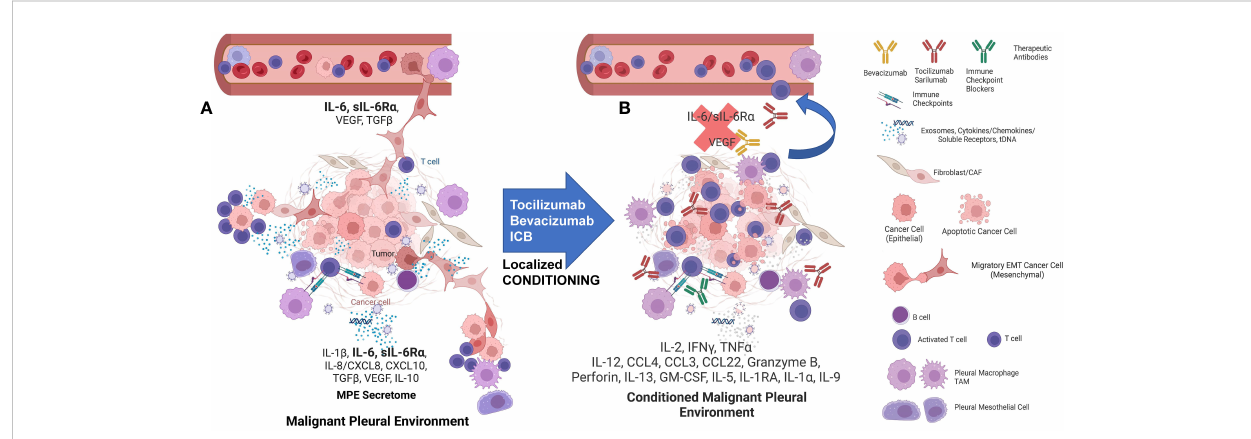
FIGURE 7 The interactions of MPE tumor, TAM, and T-cells are highly dependent on the local environment but can be conditioned to support anti-tumor immunity and drive effector-memory T cell generation. (A) MPE Tumor effects on TAM: Tumor, particularly tumor that has undergone EMT, ampli fi es and maintains TAM M2-like wound healing polarization. TAM are recruited with tumor-secreted G-CSF, IL-6, IL-8, CCL2/MCP1, CXCL1/GRO, G-CSF, GM-CSF, TGF b and CD90/CD11b interactions. IL-6 secreted by the tumor and the M2 TAM also acts as a potent growth factor on pleural mesothelium in the presence of soluble IL-6R a . MPE Tumor and TAM polarization effects on pleural T cells: M2 TAM polarization favors T-cell suppression through cytokines (IL-6, TGF b , IL-1RA, IL-10) and programmed death ligand-induced apoptosis. The pleural space is isolated from the systemic circulation, permitting the maintenance of very high local cytokine and chemokine levels, creating a pleural immune environment in which potential effector cells are maintained in a quiescent state and tumor is maintained in an aggressive mesenchymal state. EMT tumor-TAM clusters invade lymphatics and vessels, spread and seed distant metastases. (B) The pleural environment is conditioned by local delivery of cytokines, activation signals, antibody-based therapeutics and ex-vivo activated PIT, tipping the balance in favor of the immune effector response. Local “ conditioning ” therapy results in M1 TAM polarization, providing presentation of tumor associated-antigens and costimulatory signals, culminating in the maintenance and expansion of tumor-speci fi c effector T cells. Once the immune suppression has been lifted, antigen presenting cells and effector-memory T cells can traf fi c to the draining lymph nodes where responding T cells can proliferate and differentiate. Once this has occurred, tumor speci fi c effector T cells can be expected to home to other sites of metastasis. Figure was generated in